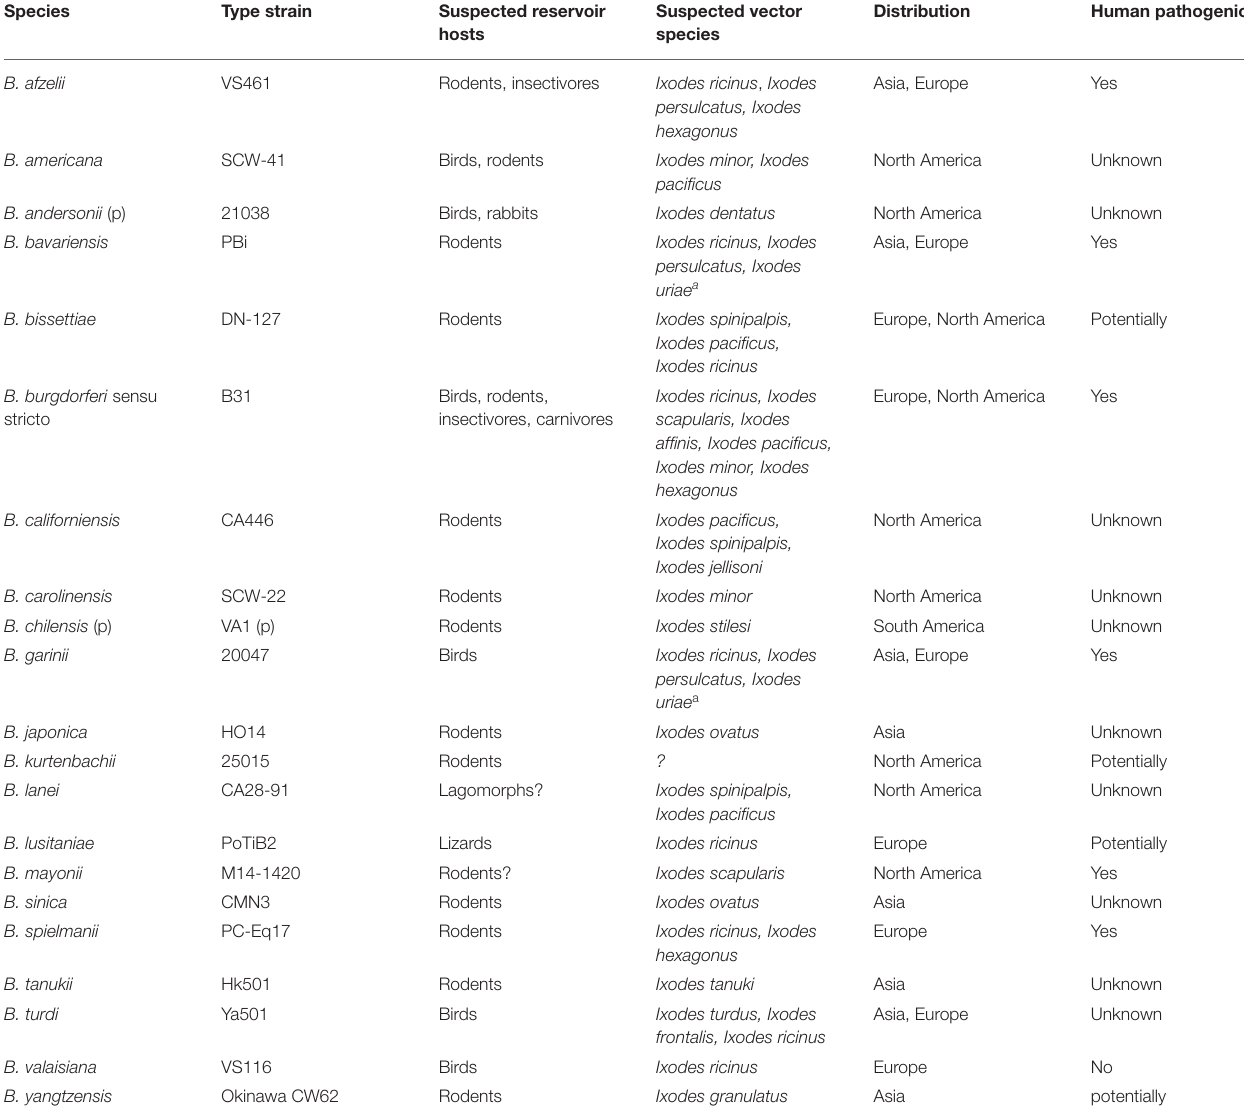
TABLE 1 | The Borrelia burgdorferi sensu lato species